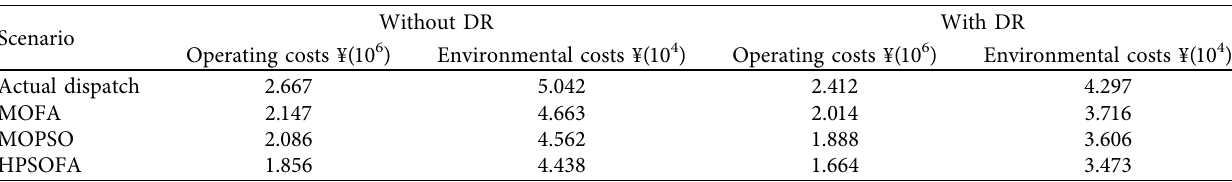
Table 7: Comparison of target costs for optimal